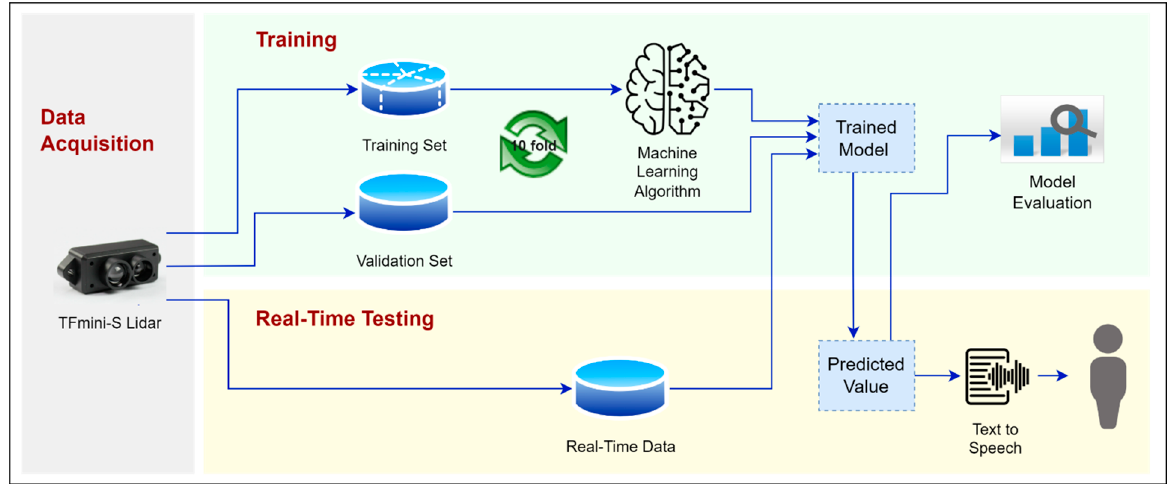
Figure 11. The machine learning module.